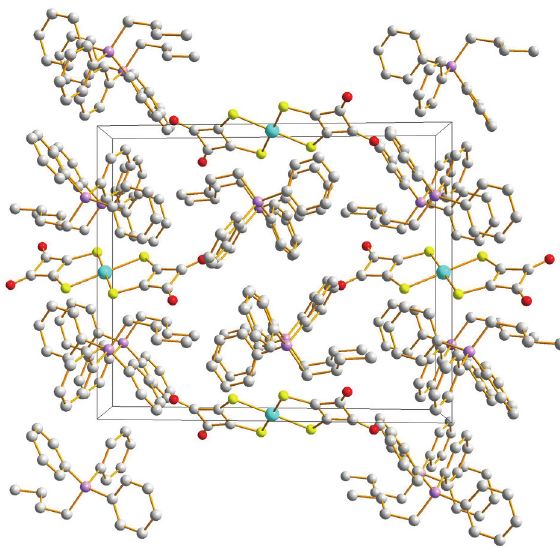
[ Ni(dtsq) ] (hydrogen P) 3 2 2